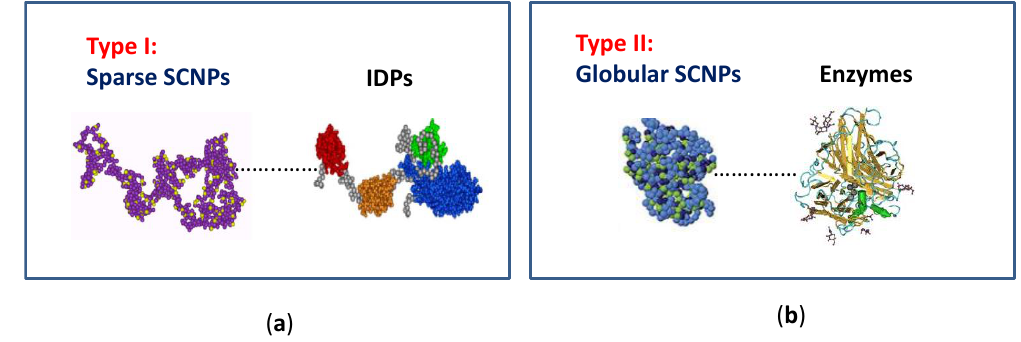
Figure 2. Illustration of the two limiting conformations of SCNPs: ( a ) sparse morphology resembling that typical of intrinsically disordered proteins (IDPs); and ( b ) globular morphology as often found in enzymes (reprinted from [9] with permission, Copyright Society of Chemical Industry, 2016).